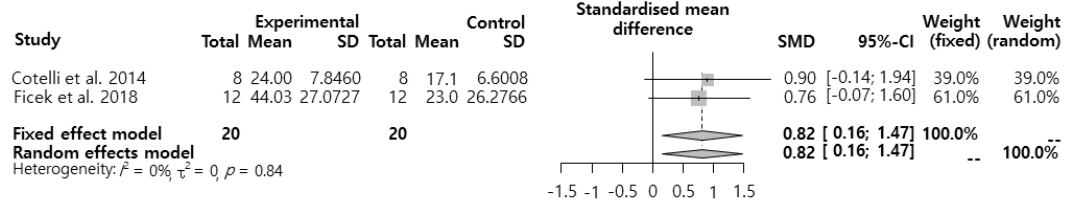
Figure 2. Effects of transcranial direct current stimulation (tDCS) intervention on patients with primary progressive aphasia ( PPA’s ) naming performance.